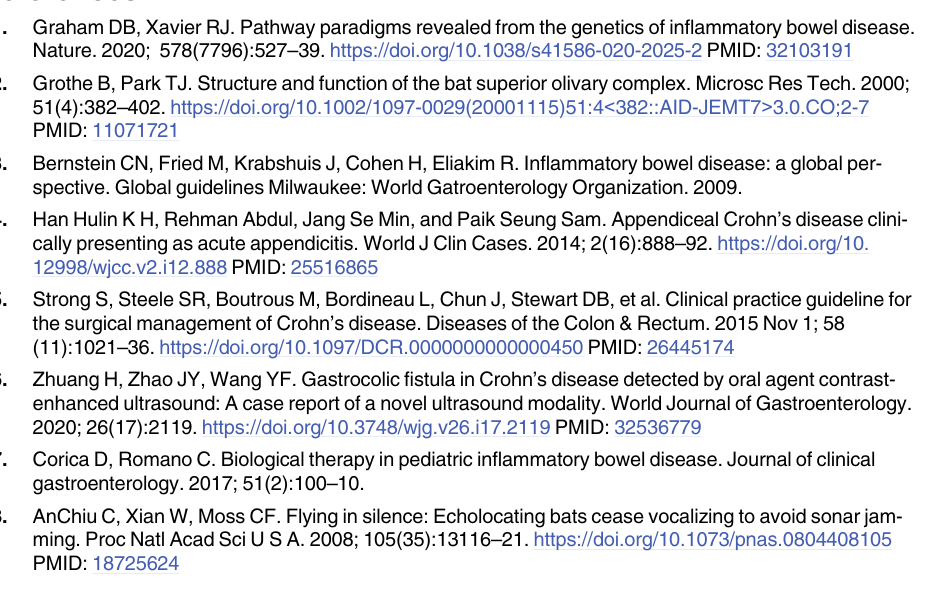
S1 Table. The methodological quality of the included studies using JBI critical appraising